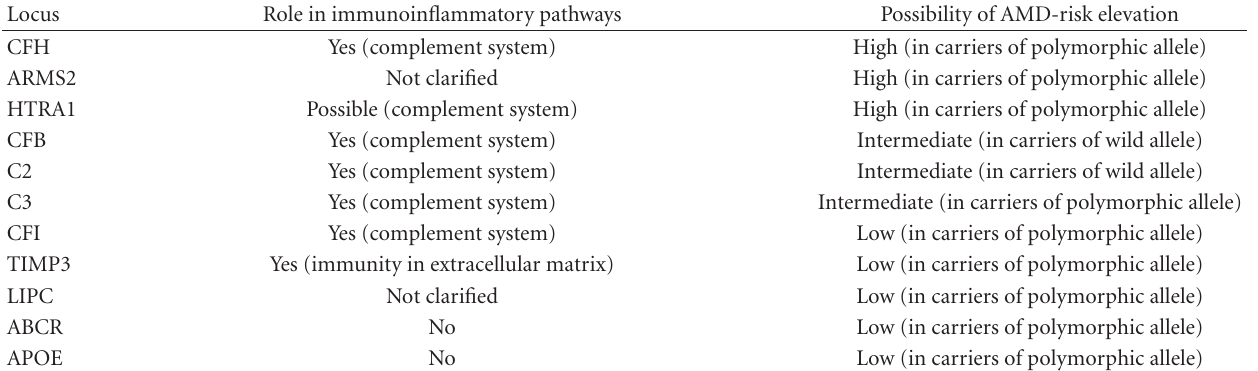
Table 1: Main AMD-susceptibility genetic